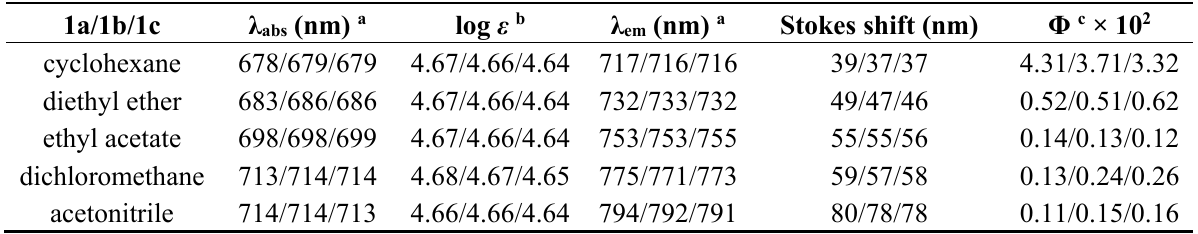
Figure 2. Normalized absorption spectra of 1a – 4a and 5 – 8 in dichloromethane solution. Table 1. Summary of optical absorption and emission properties of 1a – 1c in various solvents.